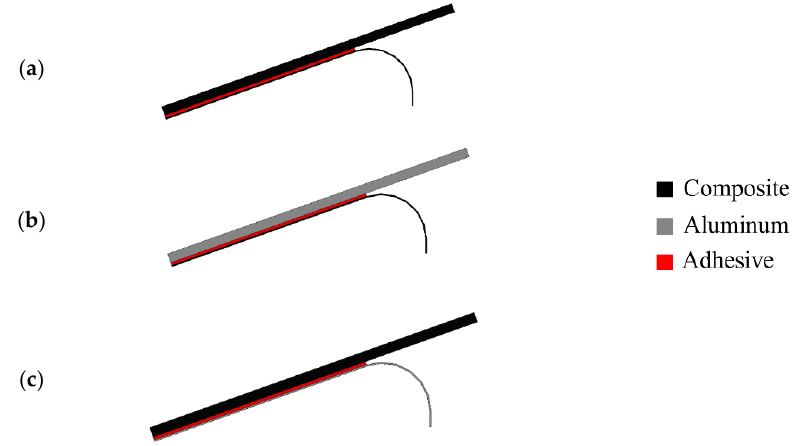
Figure 7. Peel tests for bonded ( a ) composite-to-composite and ( b , c ) composite-to-metal. Adapted from [103,104].